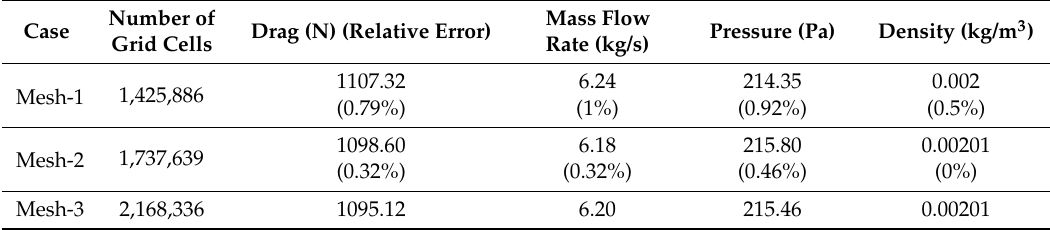
Table 1. Grid convergence test. Drag of the pod for applying the appropriate domain mesh (Mesh-2 is